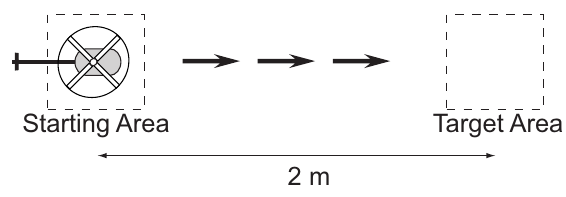
Figure 7. Proposed experiment for intercepting a designated goal